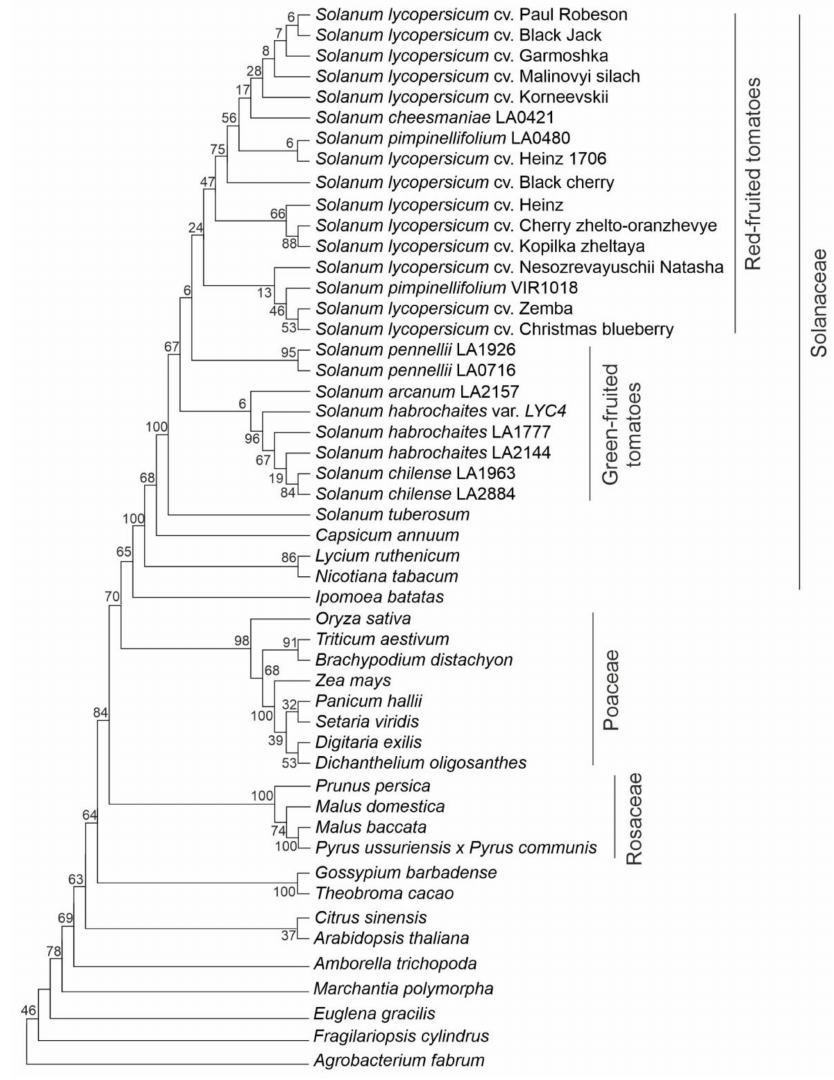
Figure 4. Evolutionary relationships among plant species based on Z-ISO protein sequences. Agrobac- terium NnrU protein was used as an outgroup sequence. Analysis was performed using the Maximum Likelihood method based on the Jones-Taylor-Thornton (JTT) matrix-based model; initial tree(s) for the heuristic search were obtained automatically by applying neighbor-joining (NJ) and BioNJ algo- rithms to a matrix of pairwise distances estimated using a JTT model; then, a topology with a superior log likelihood value was selected. A discrete Gamma distribution was used to model evolutionary rate differences among the sites (2 categories, +G, parameter = 0.6496). Percentages of replicate trees in which the associated taxa clustered together in the bootstrap test (1000 replicates) are shown next to the